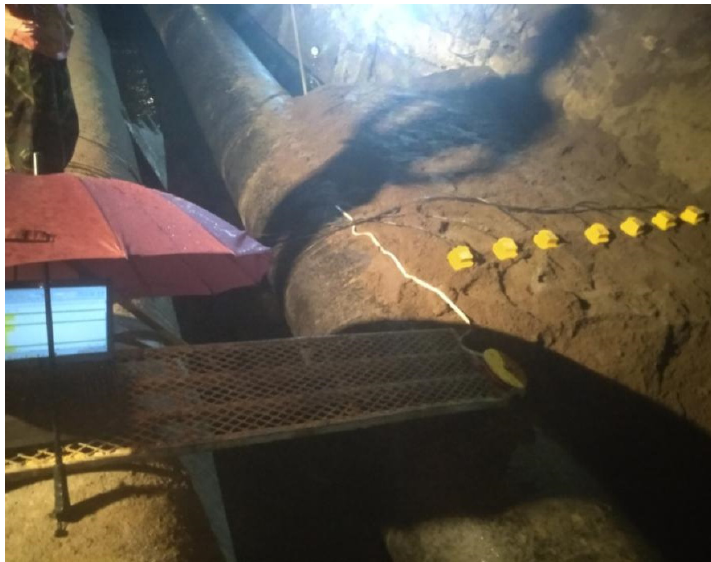
Figure 4 . Photograph showing the measurement arrangement for ground surface vibration.